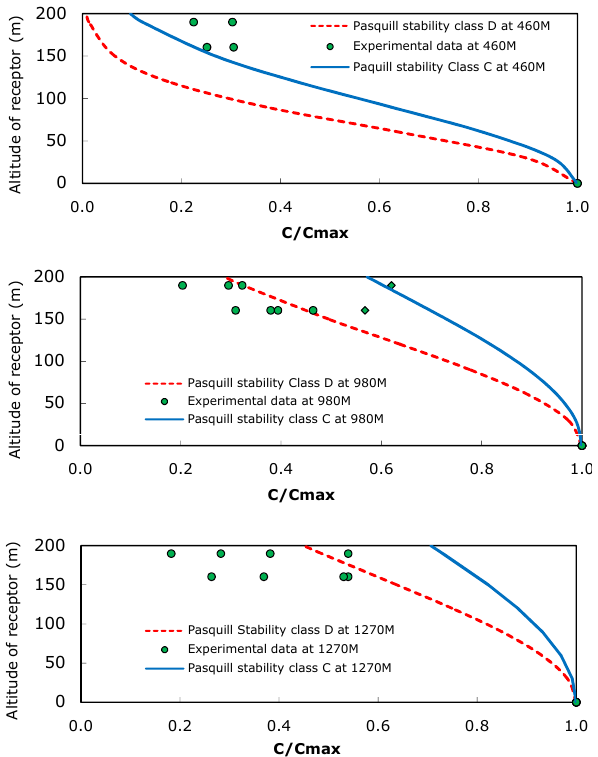
Fig. 5. Vertical gradient profiles for different source-receptor dis- tances: 460m (Experiments 4 and 5, 2007 data), 980m (Experi- ments 1–5, 2007 data); 1270m (Samples 1–4, 2006 data). Values plotted are those closest to the plume centreline. Vertical profiles are deduced from Pasquill stability classes C and D using Briggs urban parameters.